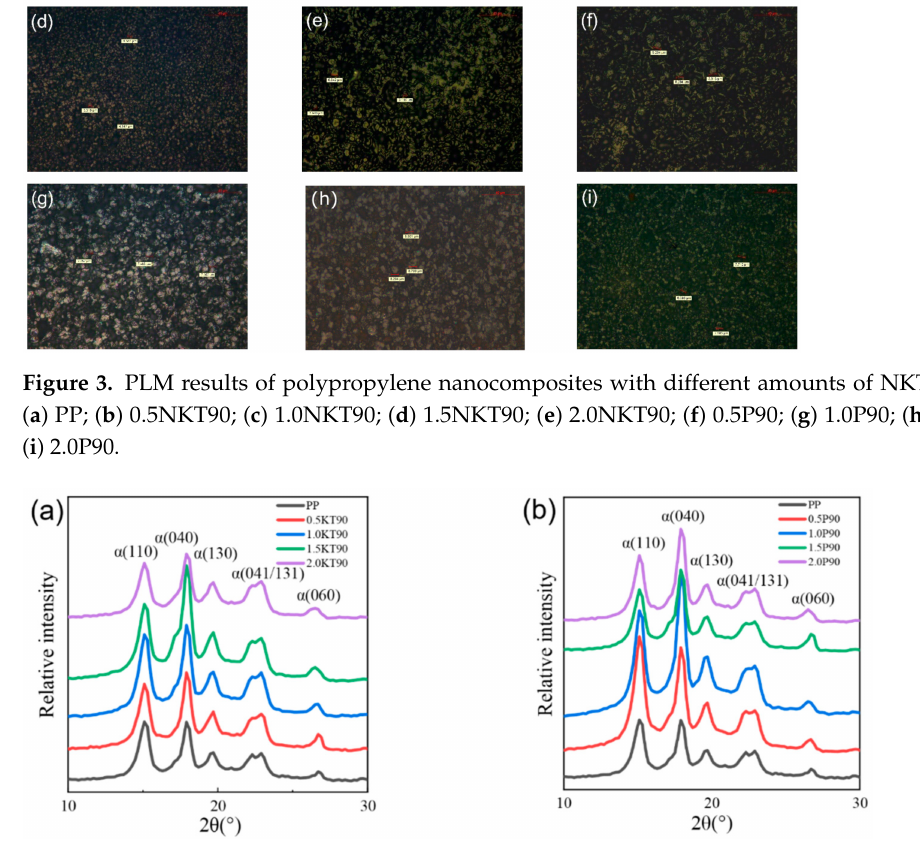
Figure 4. XRD curves of PP nanocomposites with different NKT90/P90 content. ( a ) Results of NKT90 nanocomposites. ( b ) Results of P90